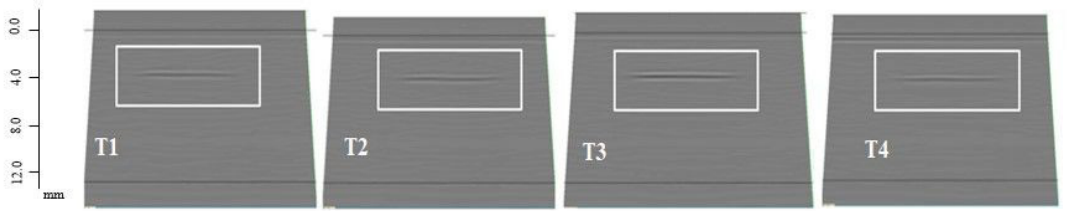
Figure 9. B-Scan image of the samples with delamination – Group T. Scale shows the depths along direction z. for sample 2 (S2), which was more difficult to identify by B-Scan